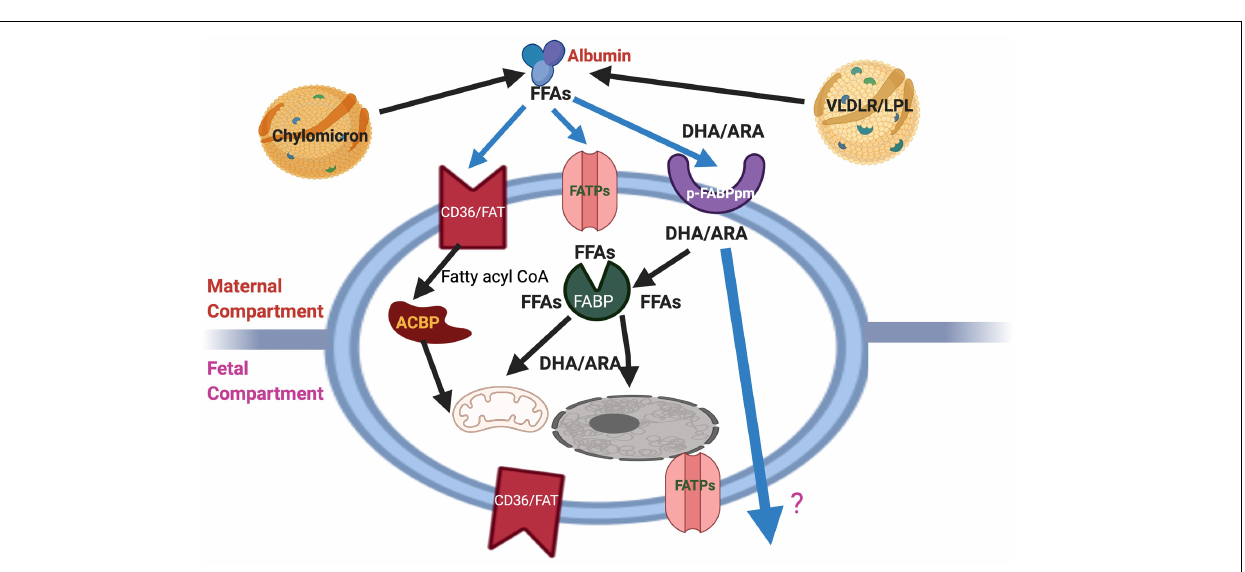
FIGURE 2 | Schematic diagram showing the cellular proteins and their involvement in the transport of maternal fatty acids across the human placental trophoblast. The schematic overview of proteins involved in fatty acid uptake and transport in last trimester trophoblast cells. The location of FAT and FATP on both sides of the bipolar placental cells and the lack of specificity for particular types of FFAs allow transport by all fatty acids bi-directionally, i.e., from the mother to the fetus and vice versa. However, by virtue of its exclusive location on both sides and preference for ARA and DHA, p-FABPpm is thought to be involved in sequestering these maternal plasma LCPUFAs to the placenta. In addition, cytoplasmic FABPs may be responsible for the trans cytoplasmic movement of FFAs to their sites of esterification, β -oxidation, or fetal circulation via placental basal membranes. FATP, Fatty acid transporter protein; pFABPpm, Plasma membrane fatty acid-binding protein; ACBP, Acyl-CoA binding